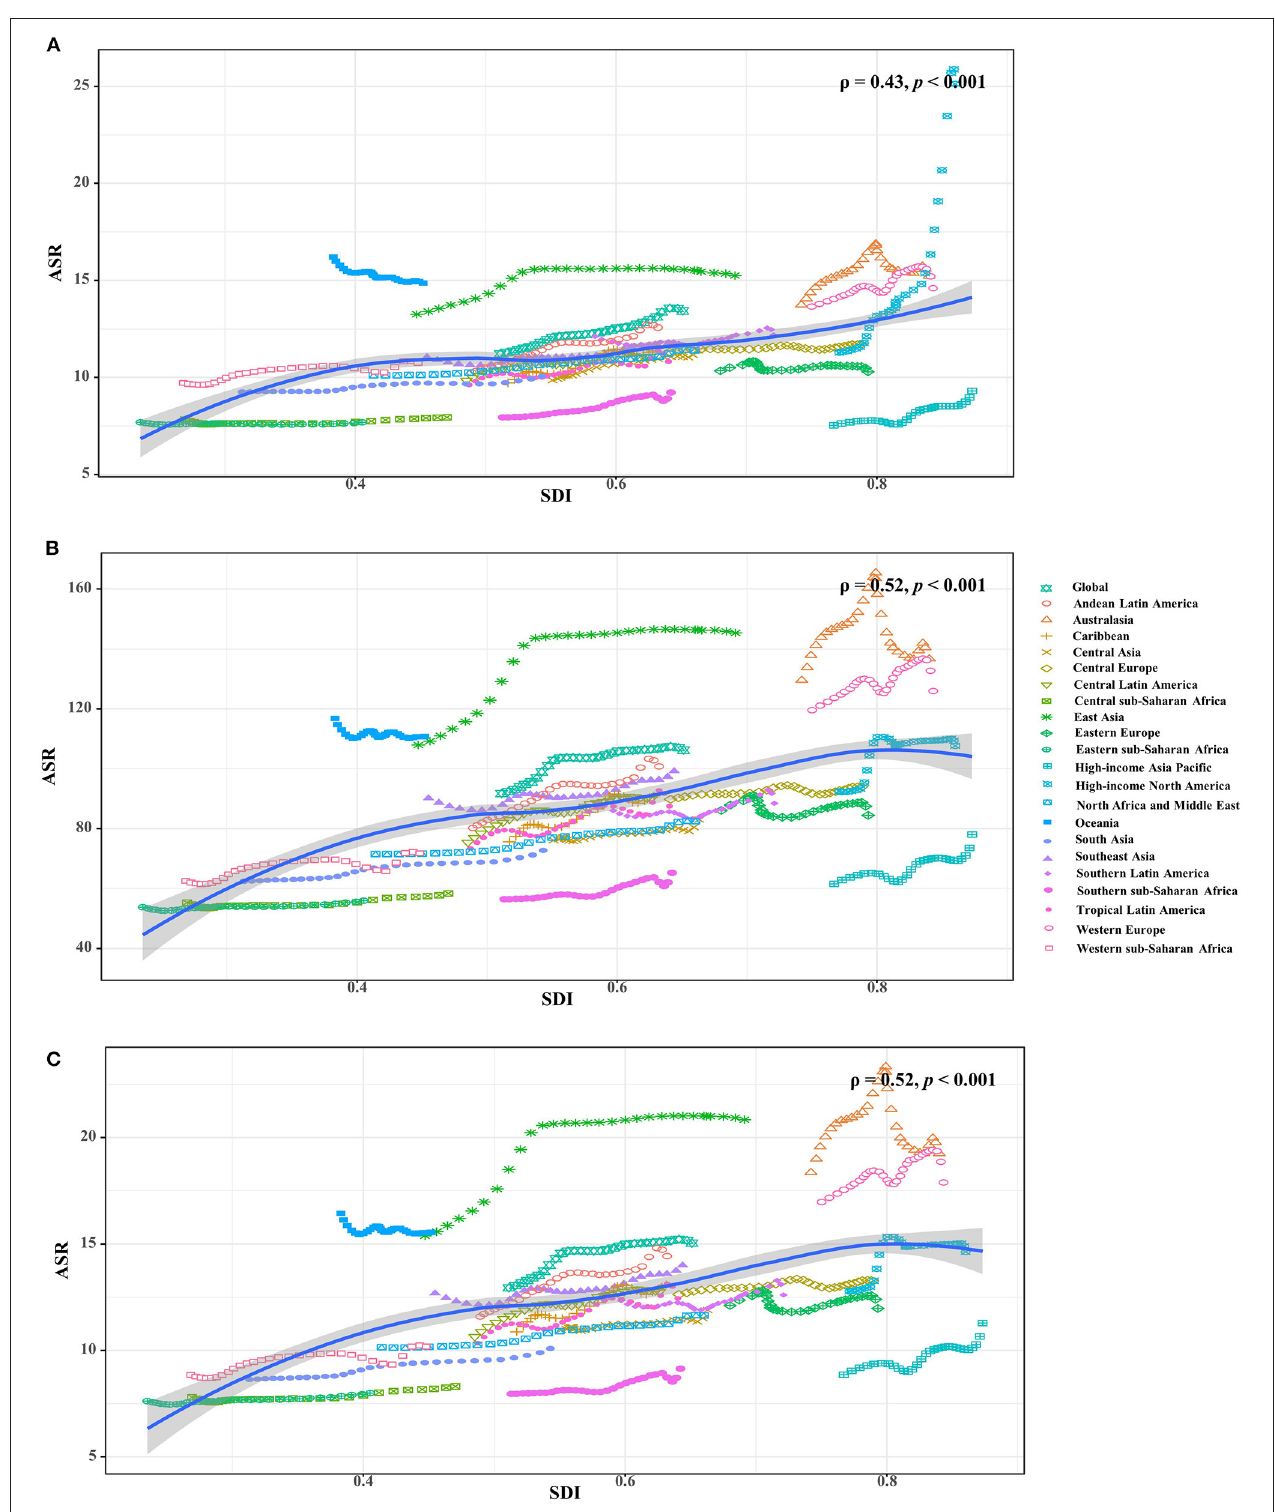
FIGURE 3 | The associations between ASRs of Parkinson’s disease and SDI in 2019 among regions. (A–C) were that of incidence, prevalence and YLDs, respectively. The points correspond the ASRs of the locations in the years from 1990 to 2019. The association was calculated with Pearson correlation analysis. ASR, age-standardized rate; SDI, socio-demographic index; YLDs, years lived with disability.